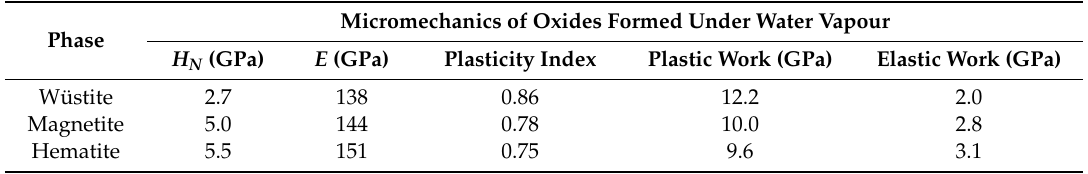
Table 3. Comparison of micromechanical properties of wüstite, magnetite, and hematite. Phase